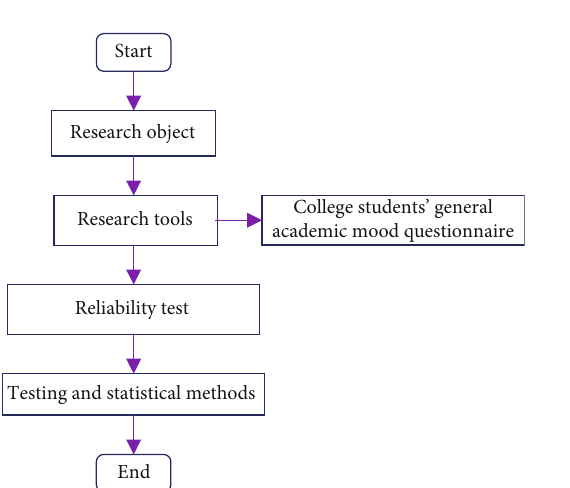
Figure 5: The rating scale of a questionnaire.